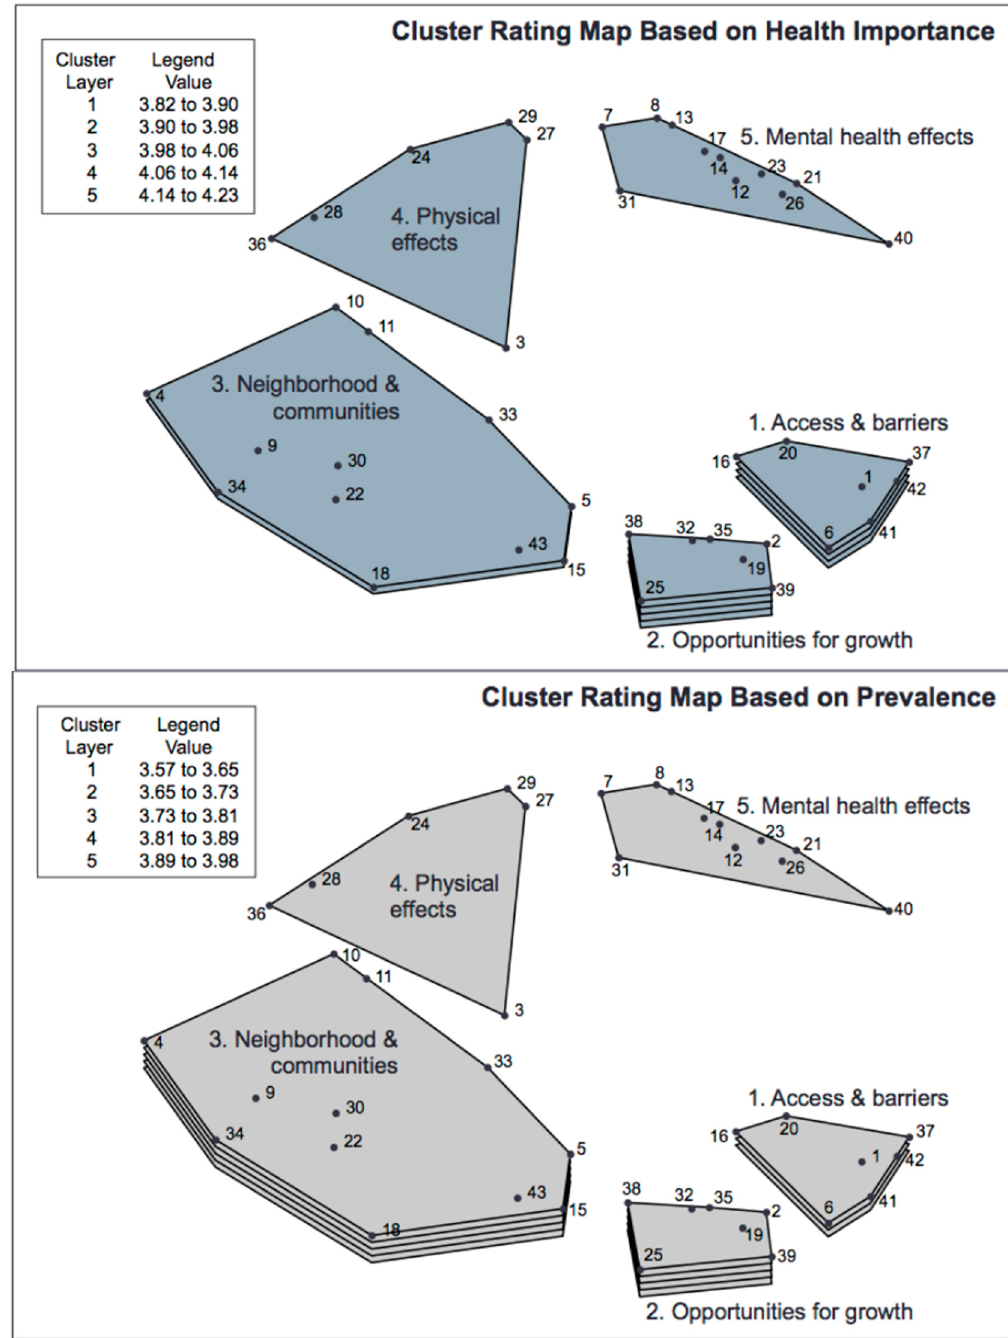
Figure 1. Cluster rating maps based on rating scores for health importance and prevalence.